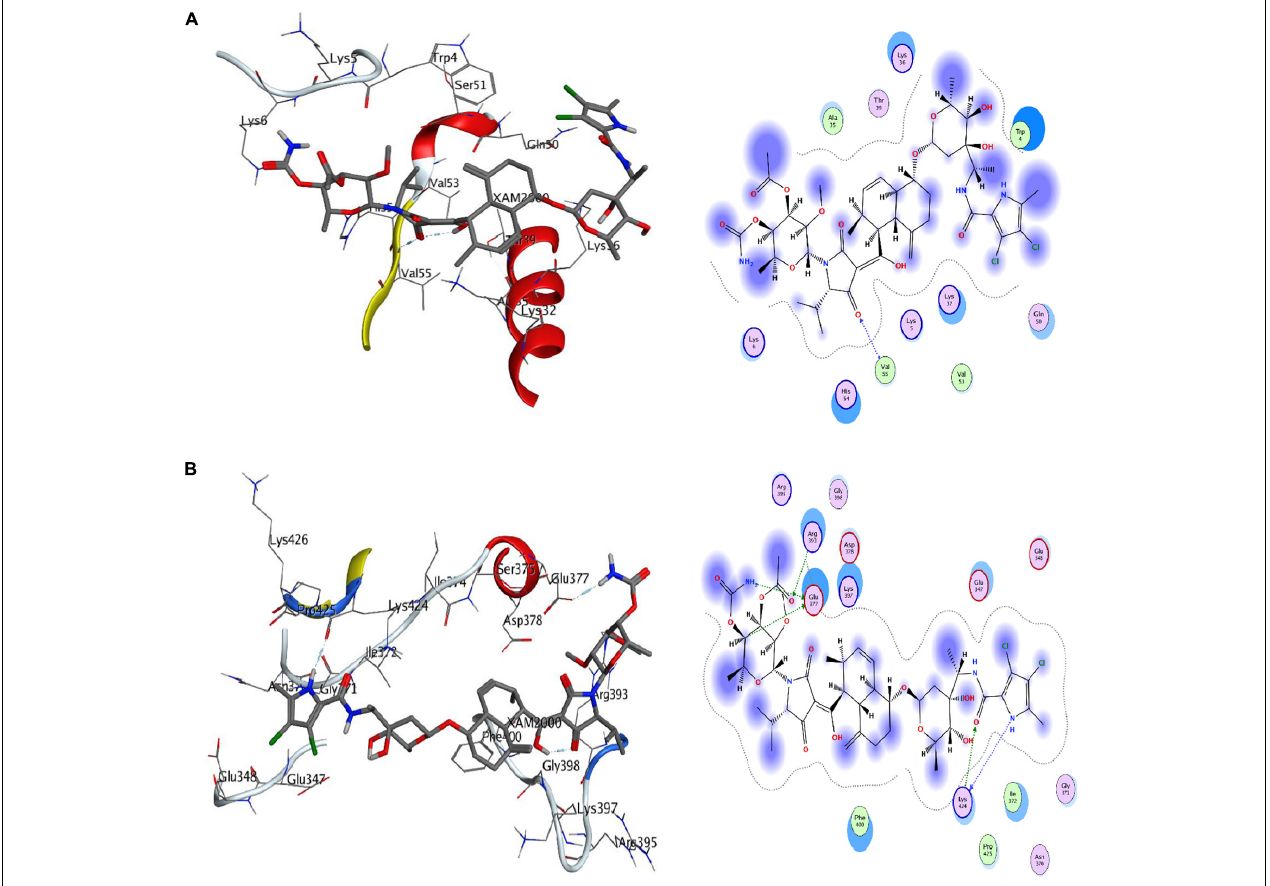
FIGURE 6 | Docking of ligands with their respective drug targets. (A) 3D and 2D interaction of DPM with Ciah protein, and (B) XAM ligand for XylH protein.